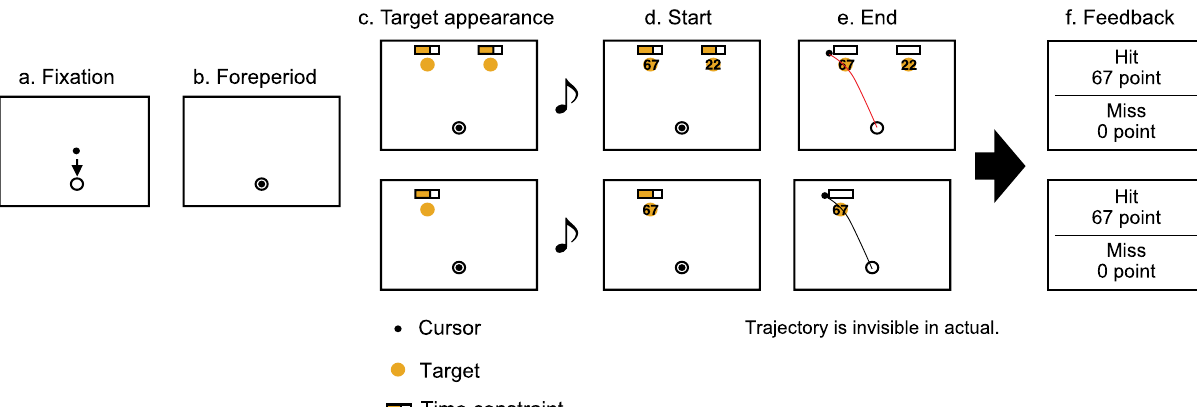
Figure 1. Trial sequences. The upper row shows the double-targets condition, and the lower row show the single-target condition. In all conditions, ( a ) at the beginning of a trial, the cursor was moved to the starting position. ( b ) After a 1-s delay period, ( c ) two targets or one target and an indicator showing time constraint were presented. After 1800–2200 ms of the target appearance, ( d , e ) the score was presented on each target with the auditory go signal, and the yellow range of the indicator starts to decrease. After the auditory go signal, the participant could perform the reaching movement freely. If the participants passed through the target within the time constraint, they received the score assigned to that target. ( f ) After the completion of the movement, participants were given feedback on their success, failure, and